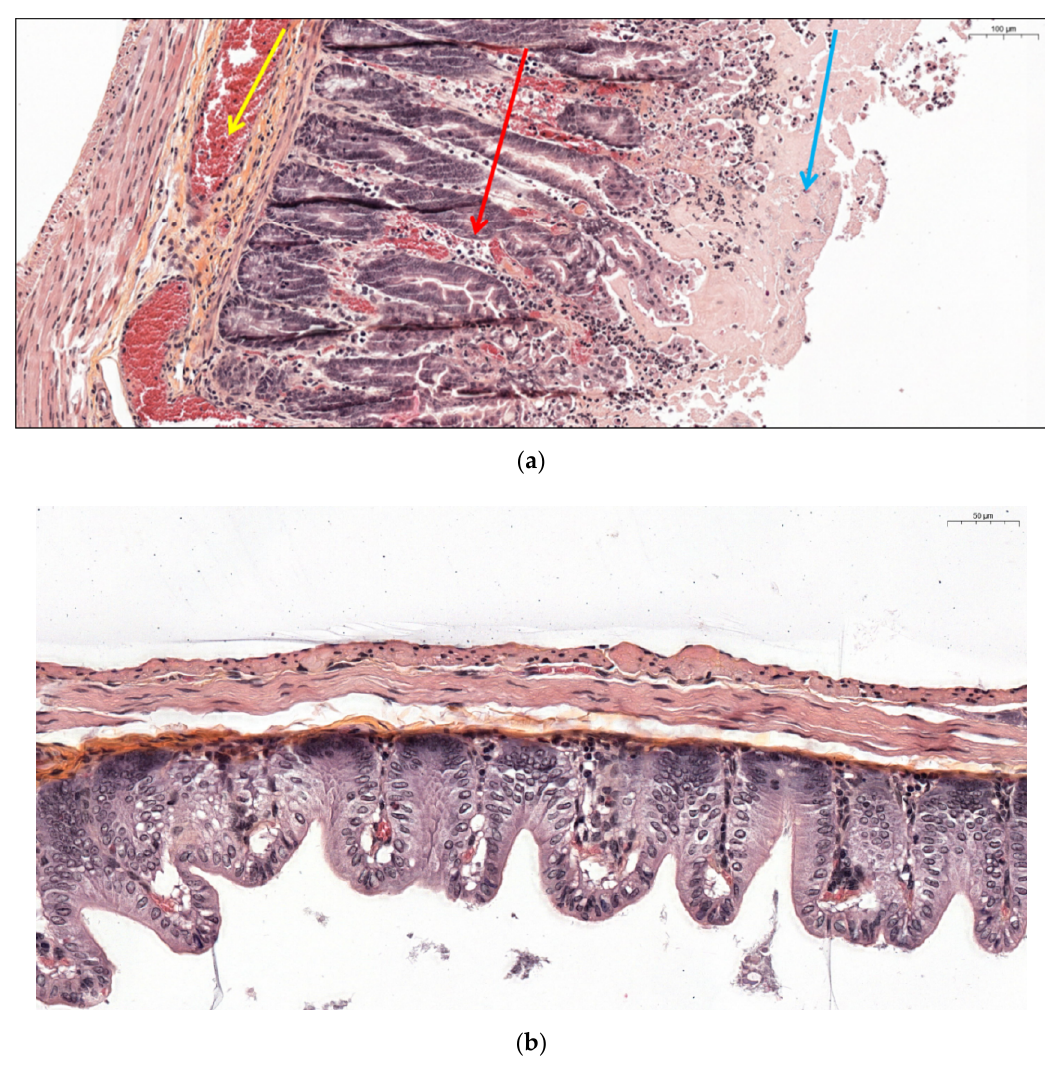
Figure 7. ( a ) Caecal histological section from a hamster co-infected by PCD130 + 027 (group D) euthanized after presenting CDI clinical signs. Diffuse hemorrhage is designated by the yellow arrow, polynuclear infiltration by the red arrow, hyperplasia and epithelial desquamation by the blue arrow. ( b ) Intestinal histological section from a hamster colonized by PCD130 (group B) surviving at D20.